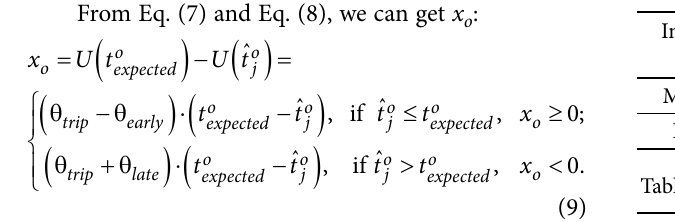
Table. 1 Different levels of car owner’s parameters